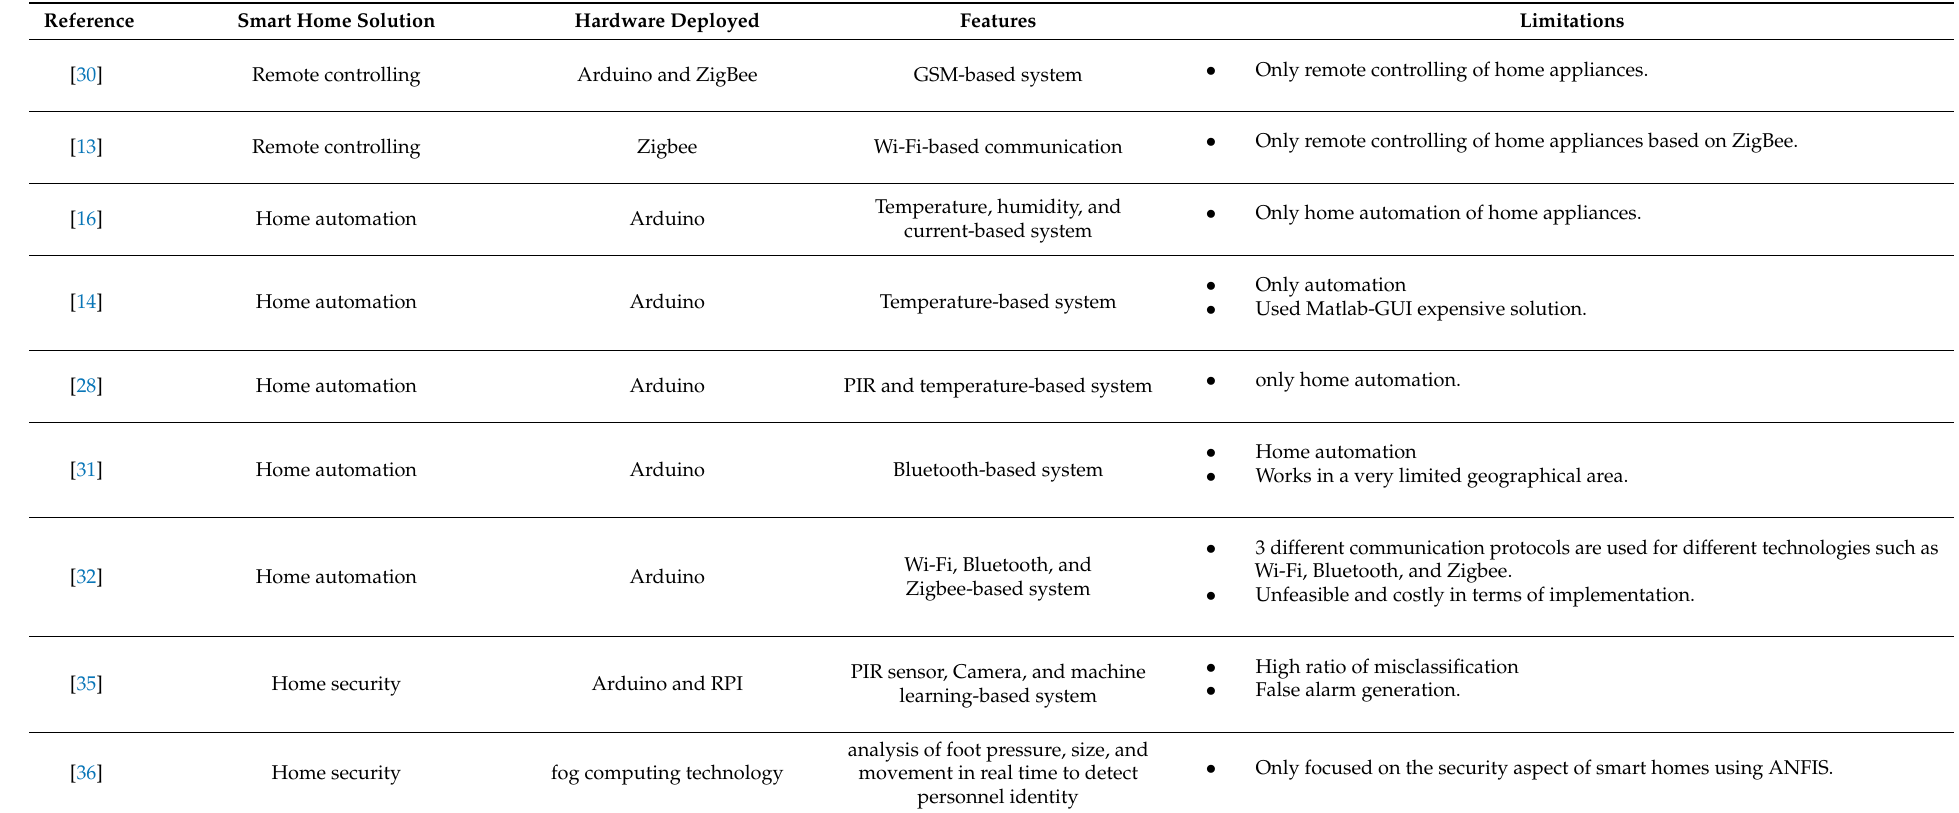
Table A1. Summary of different smart home